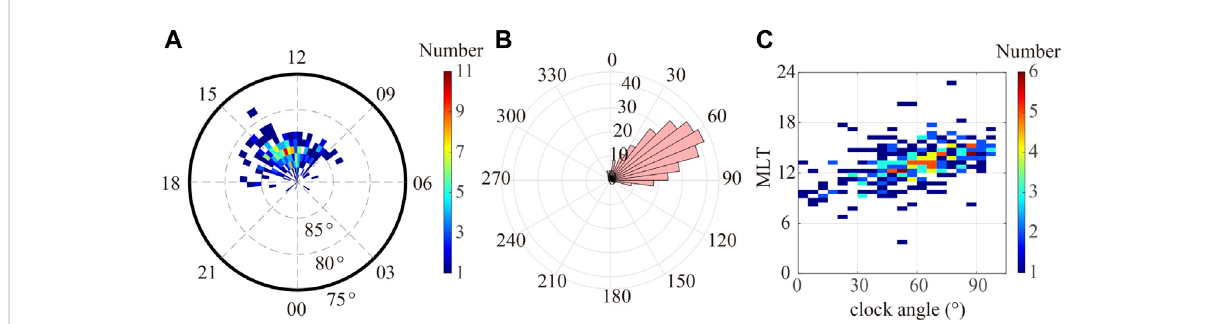
FIGURE 4 (A) MLAT-MLT distribution of space hurricane events (bin resolution 1 ° in MLAT and 24 min in MLT). (B) IMF clock angle (arctan (By/Bz)) distribution of space hurricane events. The numbers 10, 20, 30, and 40 indicate the frequency of space hurricane events in each clock angle interval (15 ° ). (C) Variation of the IMF clock angle with the MLT location of the space hurricane (bin resolution 5 ° in the clock angle and 30 min in